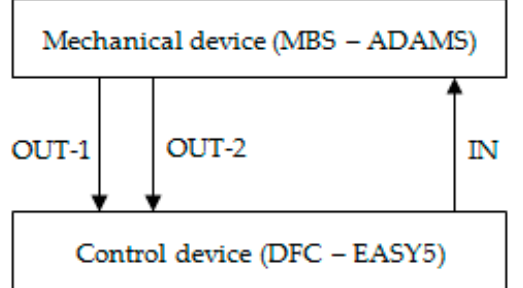
Figure 9. Scheme of communications in the mechatronic system.